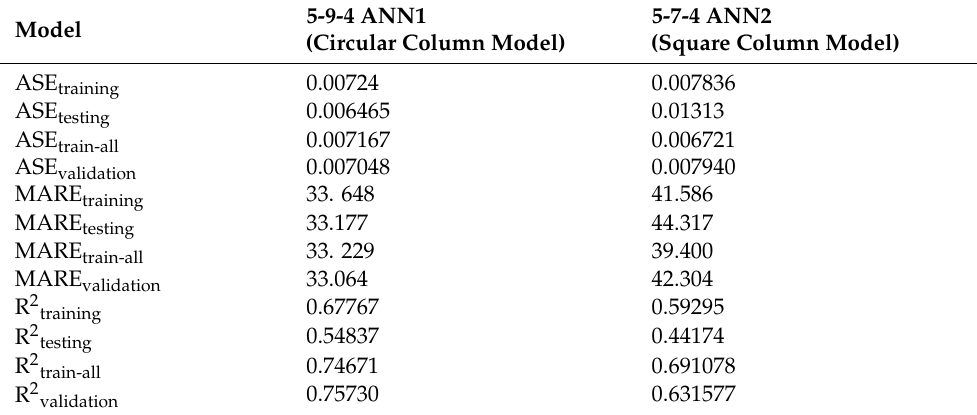
Table 5. Statistical accuracy measurements of the developed ANN